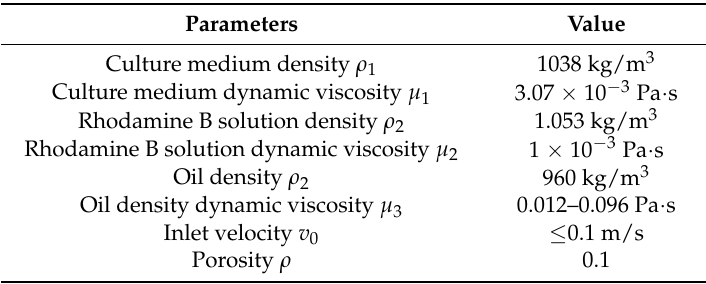
Table 1. Numerical simulation